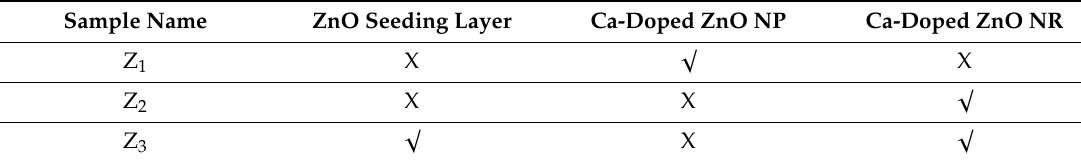
Table 2. Samples prepared for Ca-doped ZnO NP and